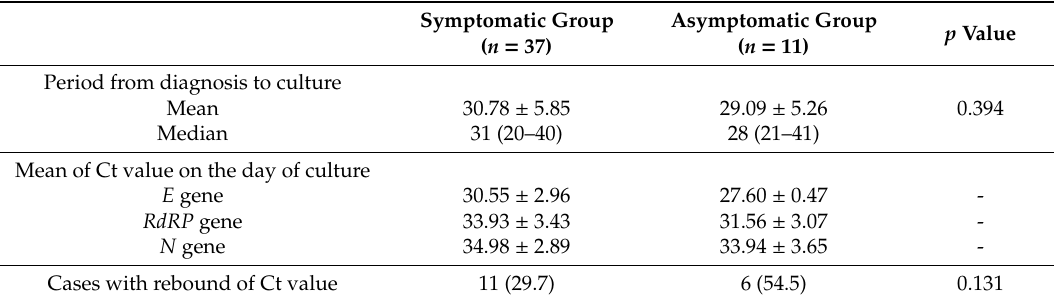
Table 2. Virologic data of patients with